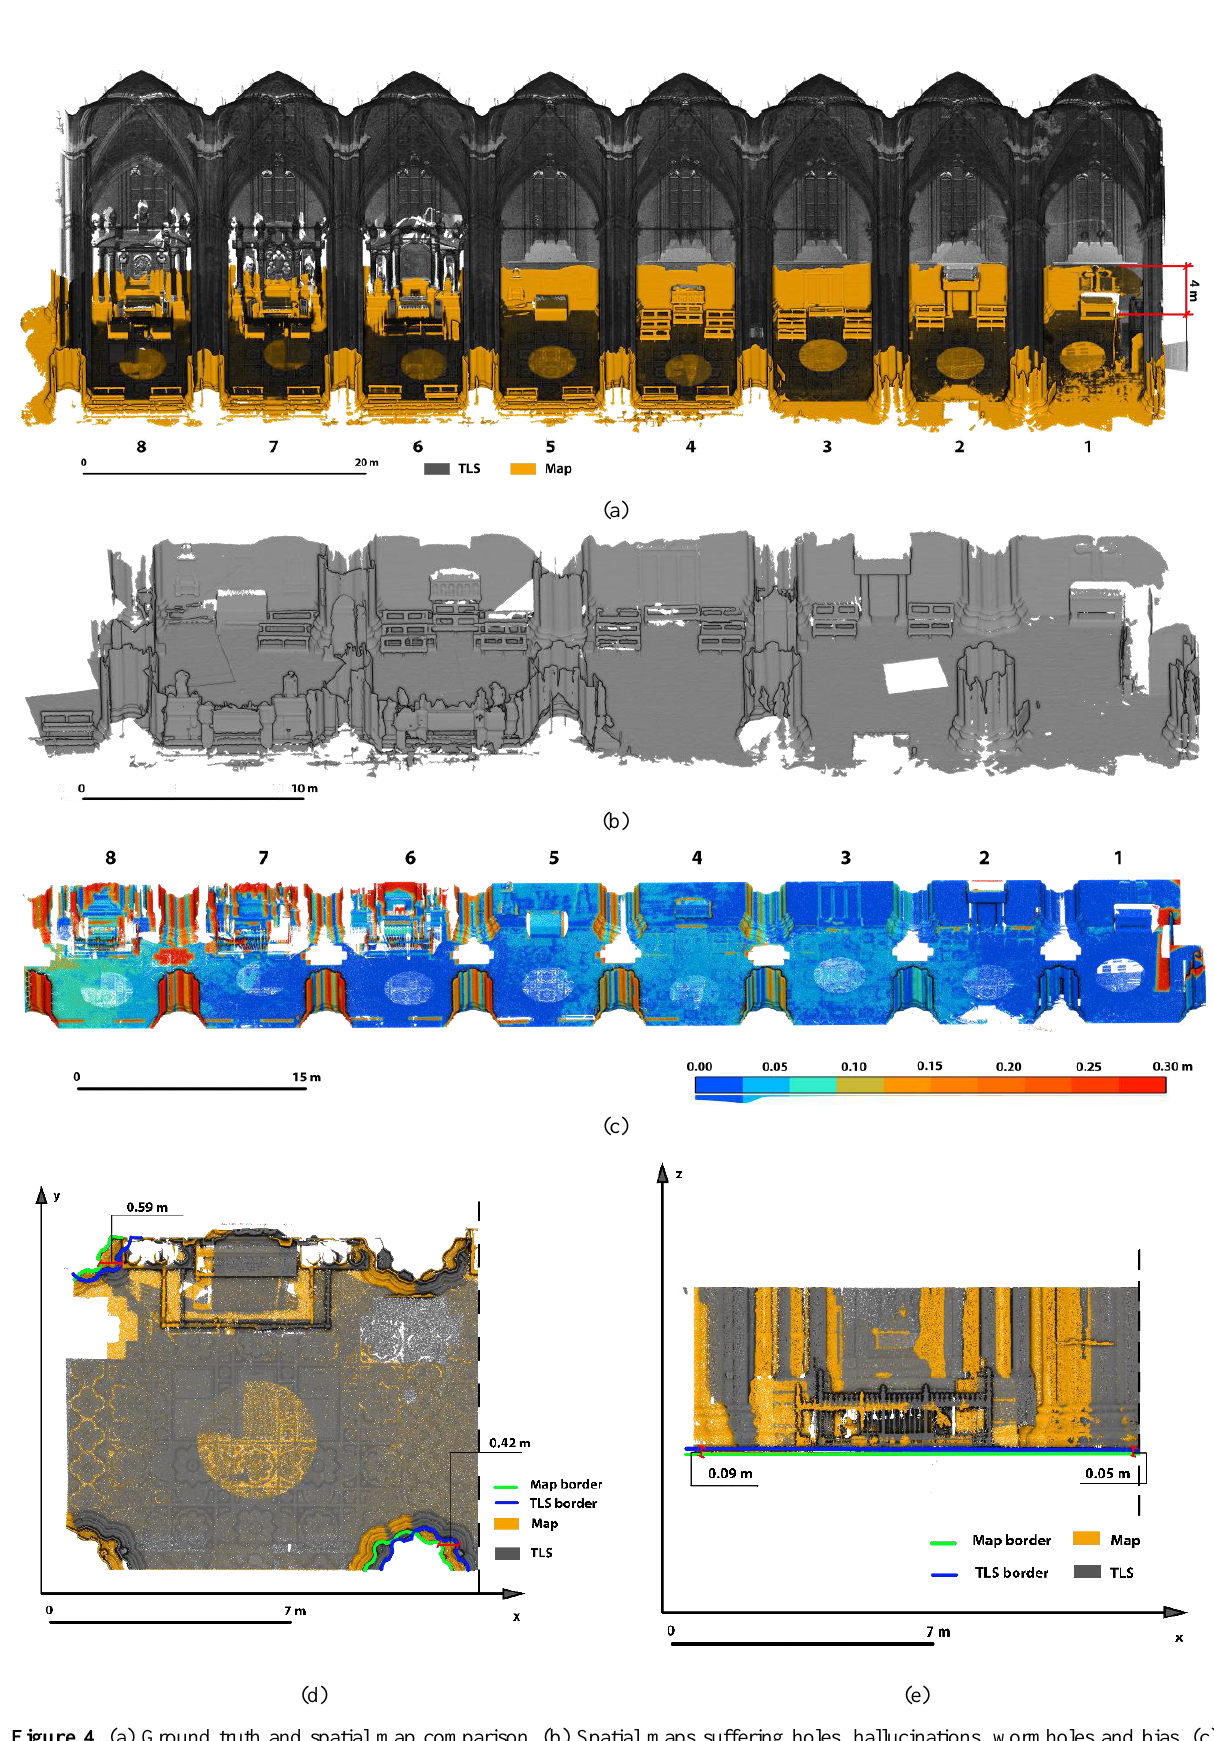
Figure 4. (a) Ground truth and spatial map comparison. (b) Spatial maps suffering holes, hallucinations, wormholes and bias. (c) Ground truth with colour-coded deviations from spatial map, (d) xy plane detail (bay 8) and (e) xz plane detail (bay